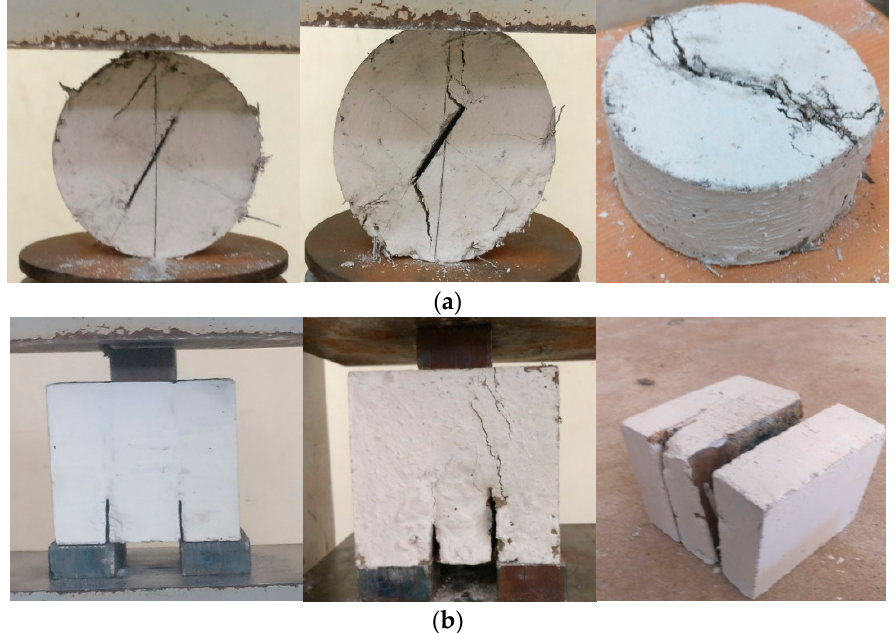
Figure 7. Failure pattern of specimens: ( a ) Brazilian cylindrical specimens and ( b ) Double notched cube